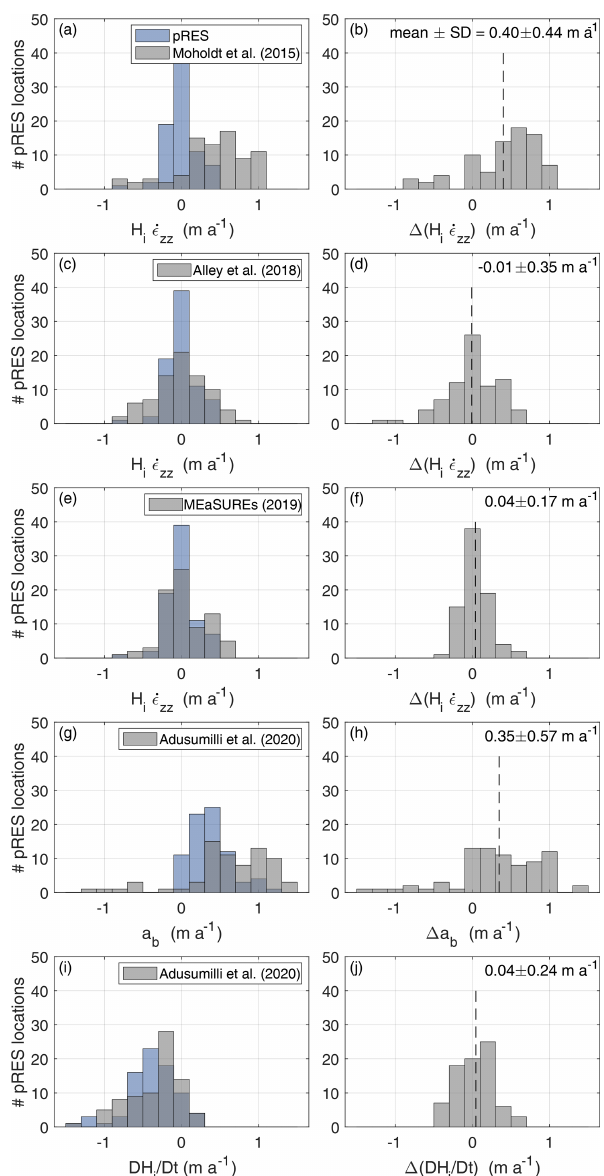
Figure 5. Comparison of remote sensing (grey) and pRES-derived (blue) results. The left column shows the distributions (a) of the dynamic change in ice thickness H i ˙ ε zz for the results published by Moholdt et al. (2015), (c) Alley et al. (2018) and (e) derived from the MEaSUREs product (Mouginot et al., 2019a, b); (g) of the basal melt rate a b ; and (i) of the change in ice thickness D H i / D t , both in comparison with those from Adusumilli et al. (2020a). The right column ( b , d , f , h and j ) shows the distribution of the deviation between remote sensing and pRES-derived values according to ( a , c , e , g and i ). The numbers in the upper right corner state the mean value and the standard deviation (SD). Positive values refer to larger numbers derived from the remote-sensing-based